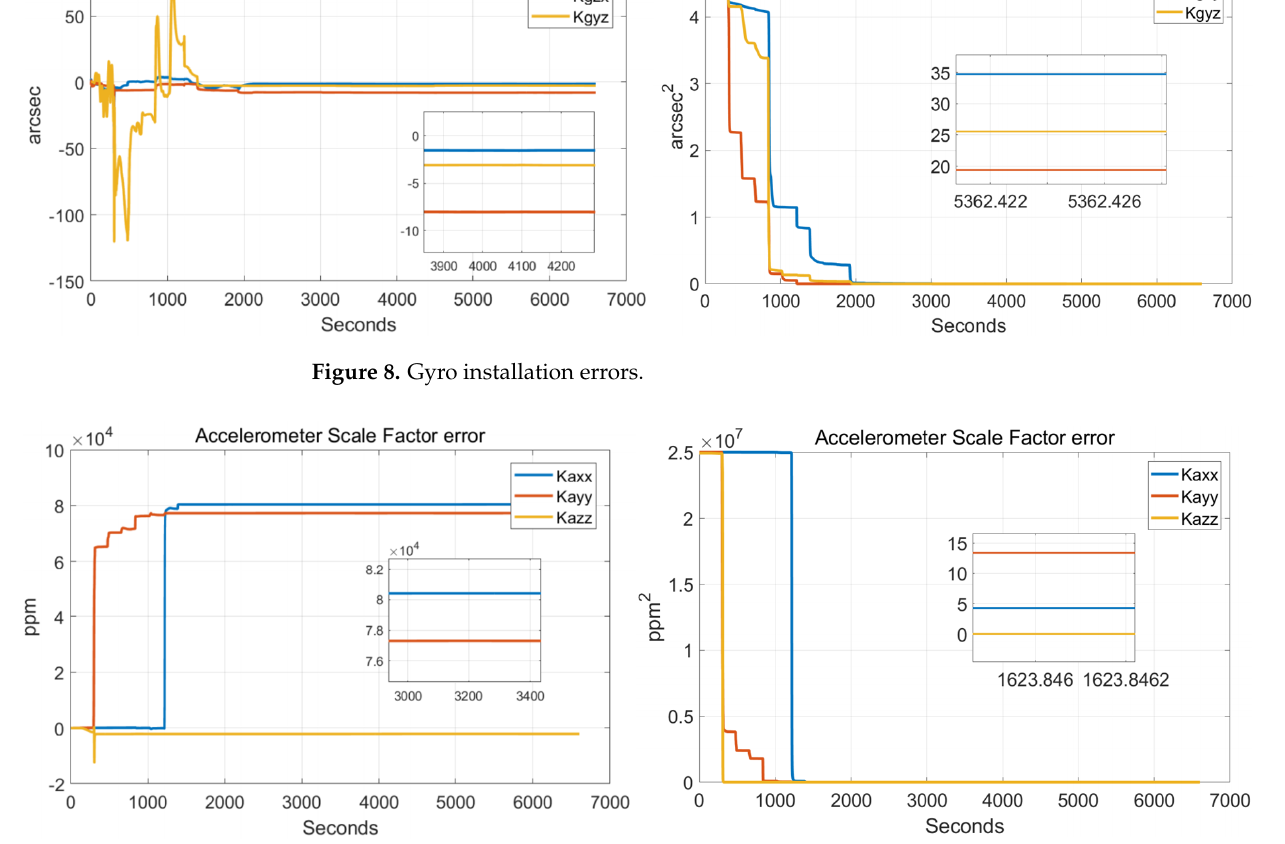
Figure 9. Accelerometer scale factor errors.